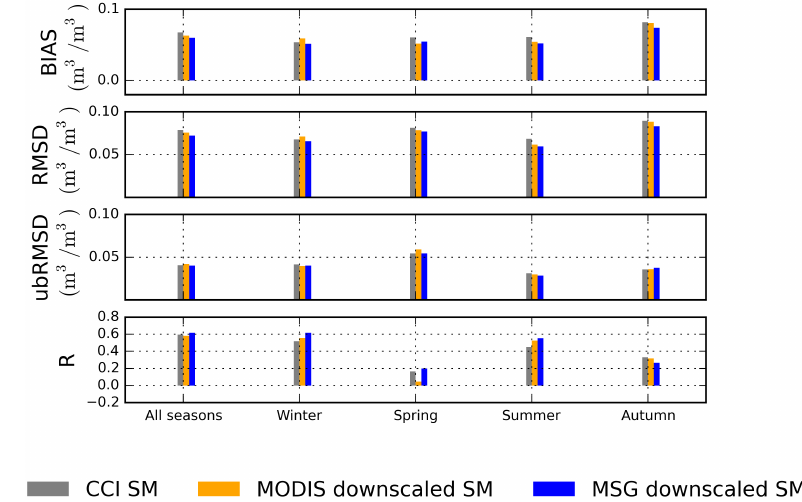
Figure 9. Bar plots for the comparisons between soils moisture estimates and in situ soil moisture over seasons.